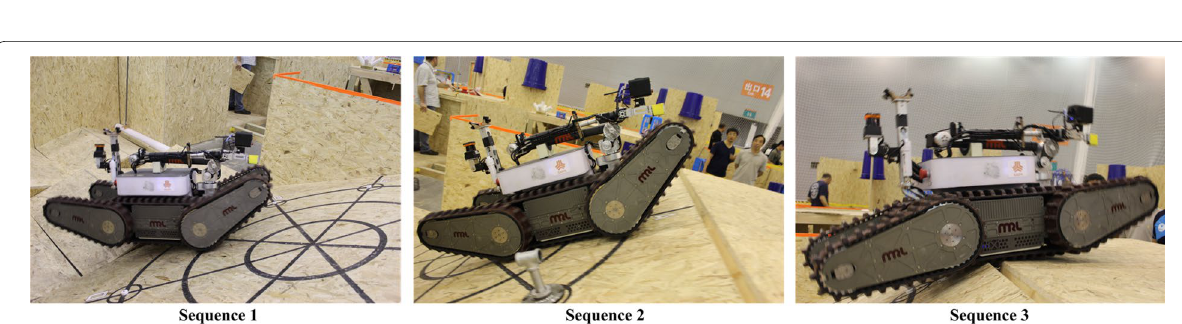
Fig. 20 Karo is fulfilling the Traverse test of the Maneuvering test